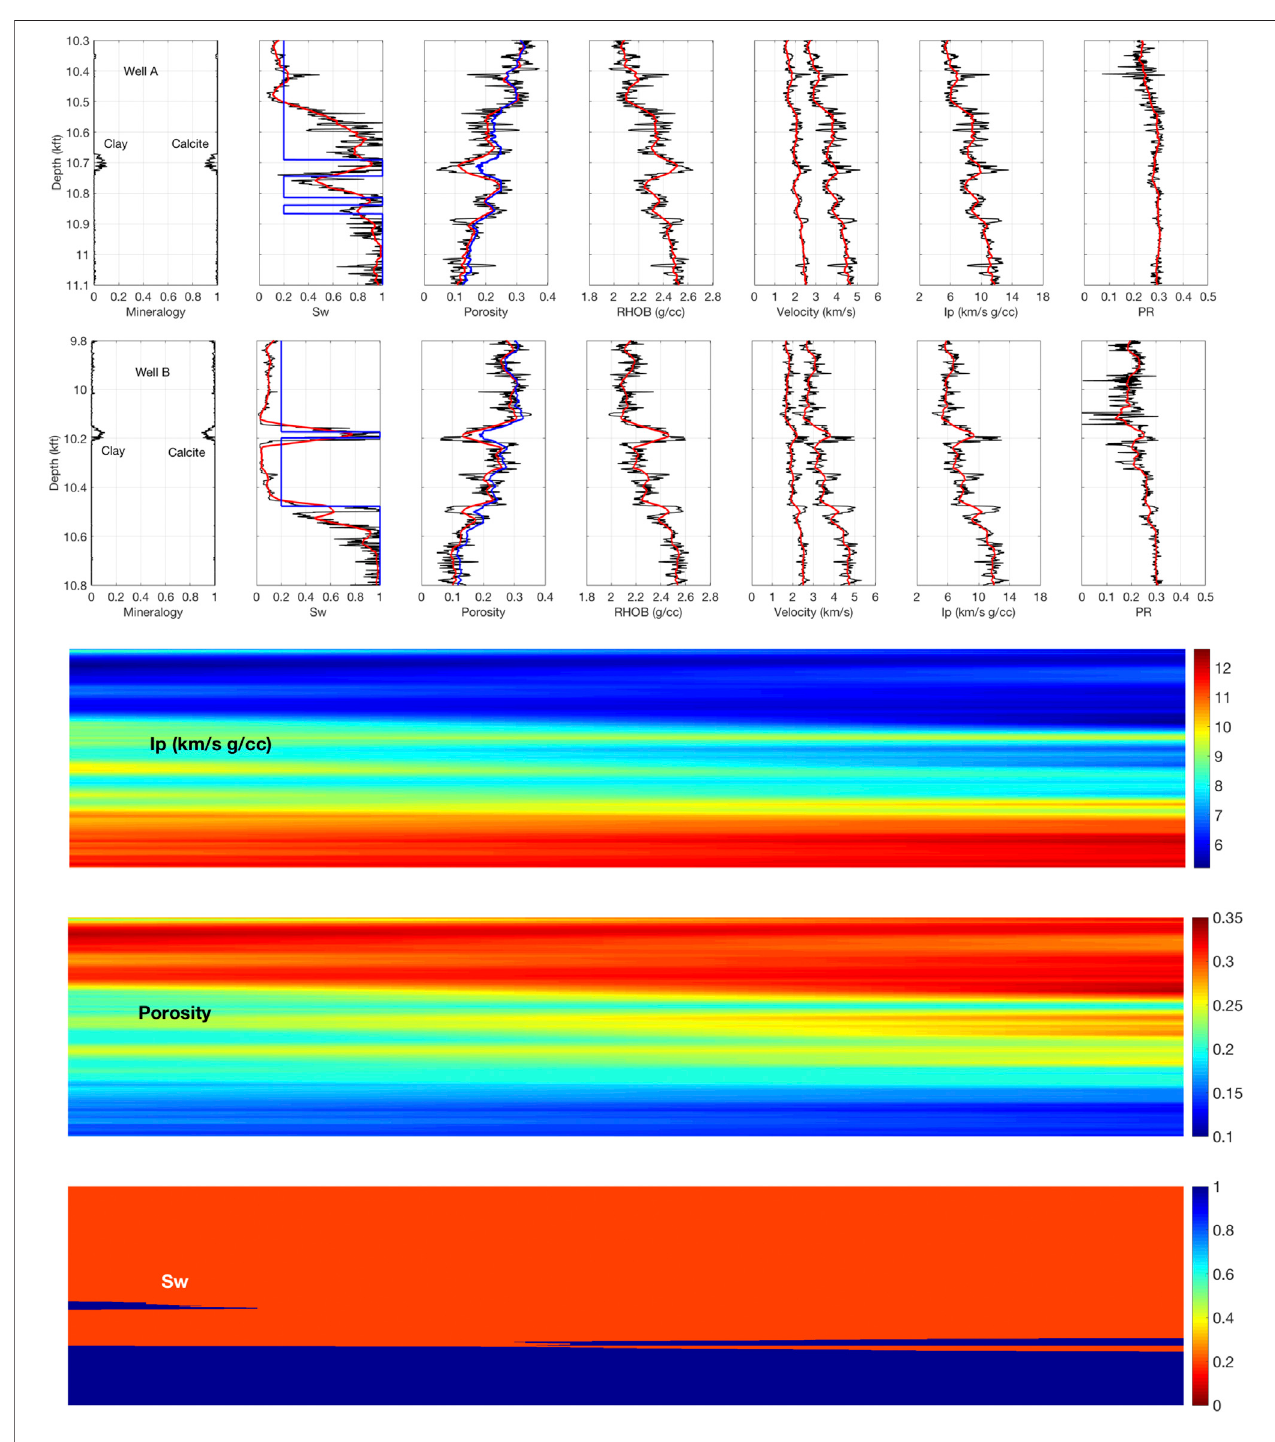
FIGURE 7 | Top two rows: Upscaled curves in Well A and B (red) and interpretation for porosity and water saturation (blue). Bottom three rows: I p pseudo-section (top) and the interpreted porosity (middle) and water saturation (bottom) sections between Well A (left) and B (right) .